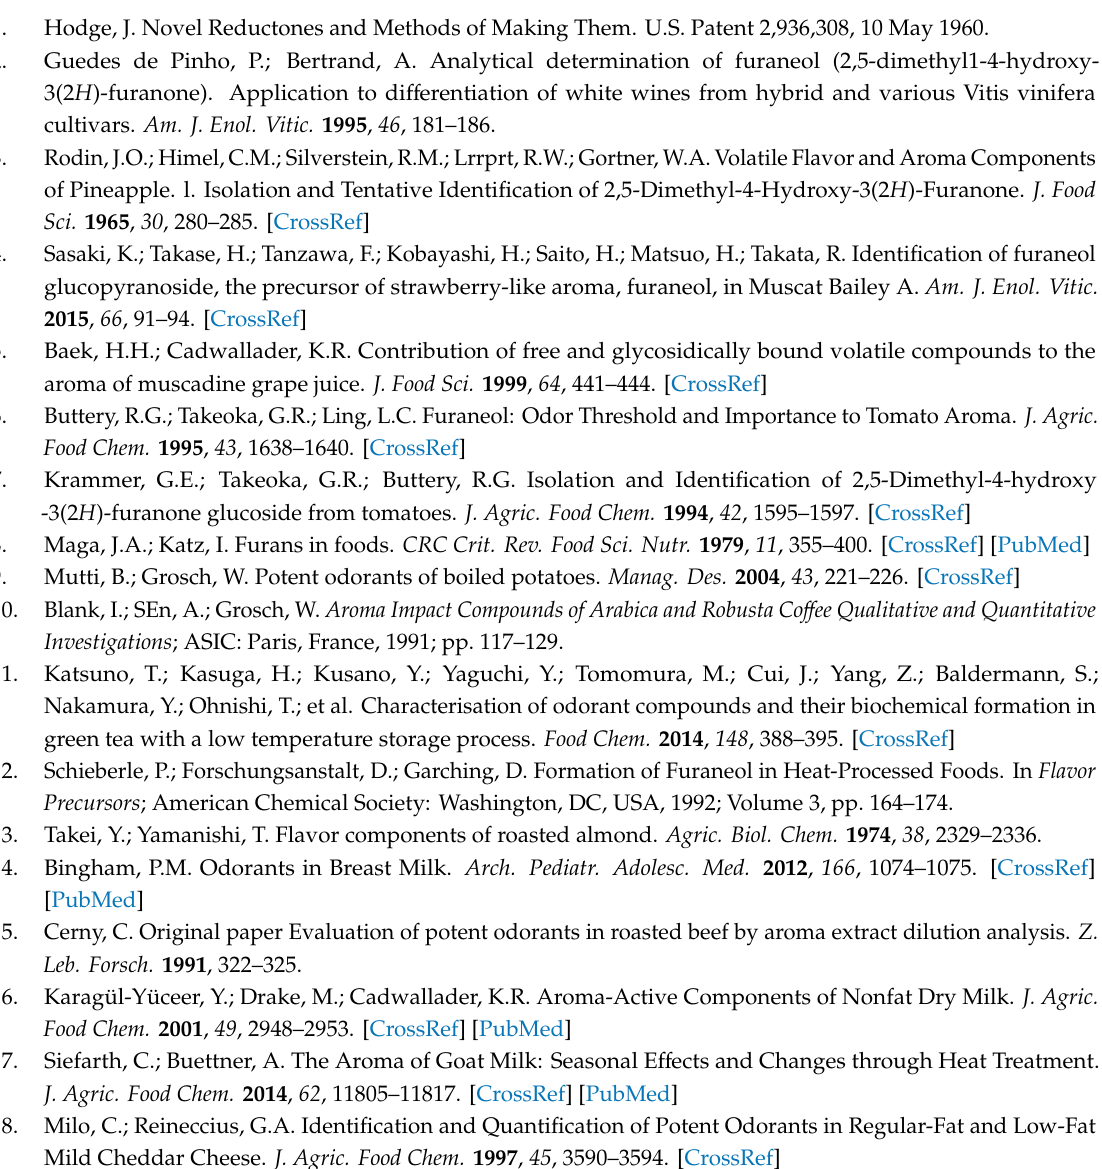
Supplementary Materials: The following are available online, Table S1: Statistical analysis of furaneol content produced at di ff erent stages during model